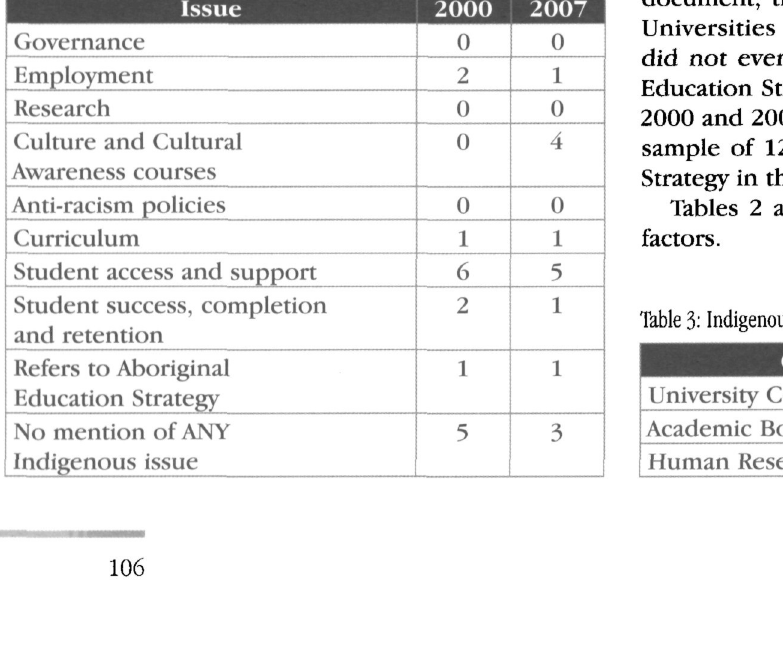
Table 2: Number of universities that mention factors in Strategic Plans.